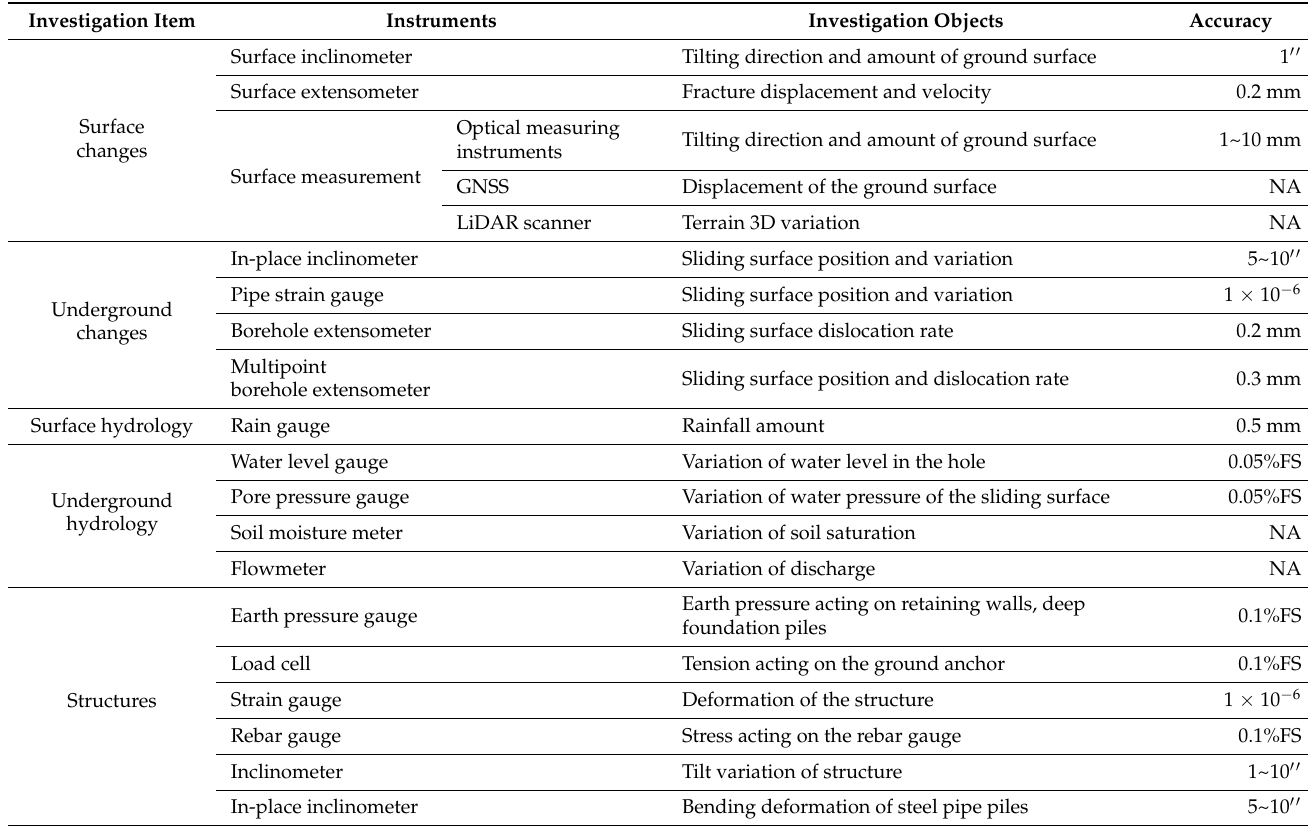
Table 1. Comparison table of on-site monitoring programs (modified from